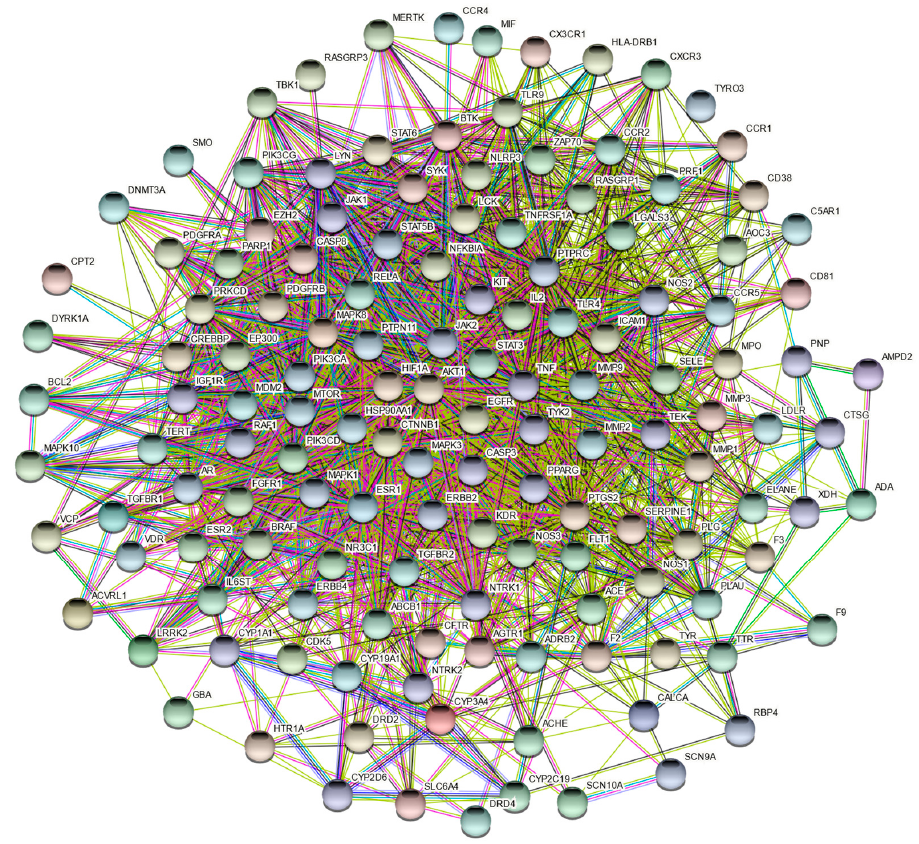
Figure 4. PPI network of common targets of ZBDHP and SLE.